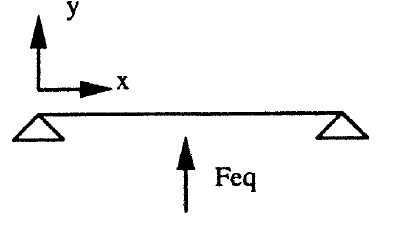
Fig. 2. Equivalent force method for a simply supported